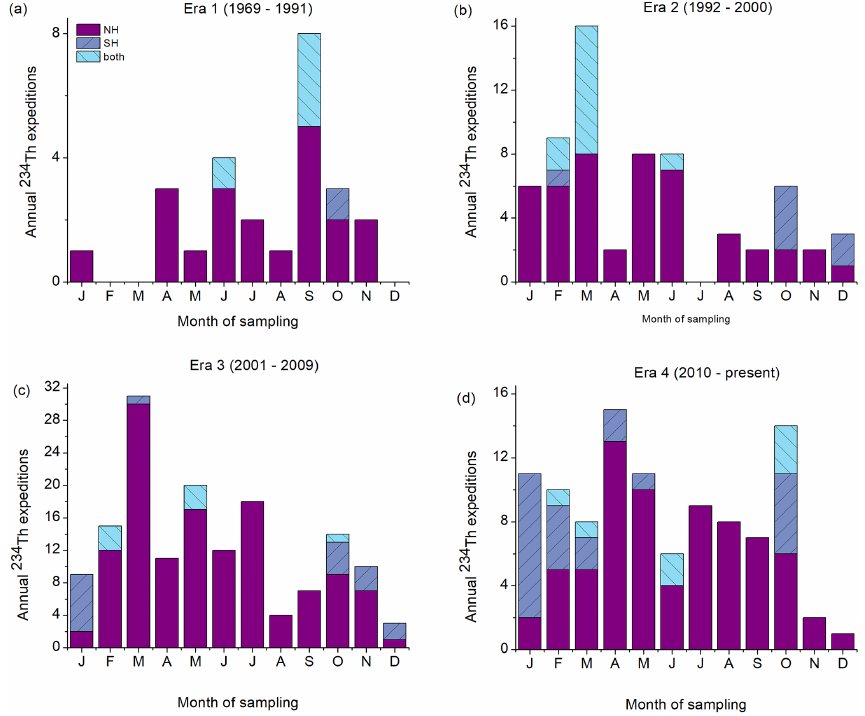
Figure 5. Seasonal distribution of annual field expeditions with 234 Th sampling reported within eras 1 (a) , 2 (b) , 3 (c) , and 4 (d) separated by hemisphere as follows: (i) Northern Hemisphere (HN), (ii) Southern Hemisphere (SH), and (iii) crossing the Equator and sampling in both hemispheres